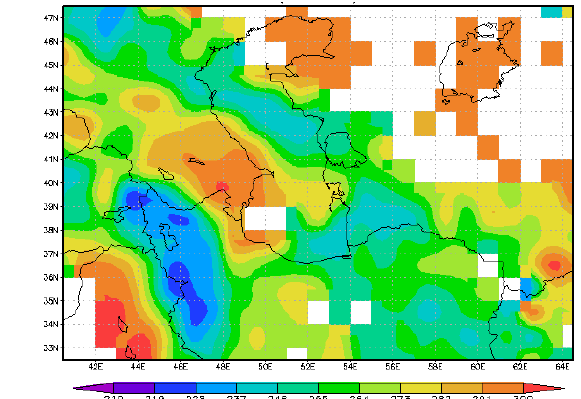
Figure 8. Cloud top Temperature from MODIS, Terra at 7:05 UTC On second of June 2014.